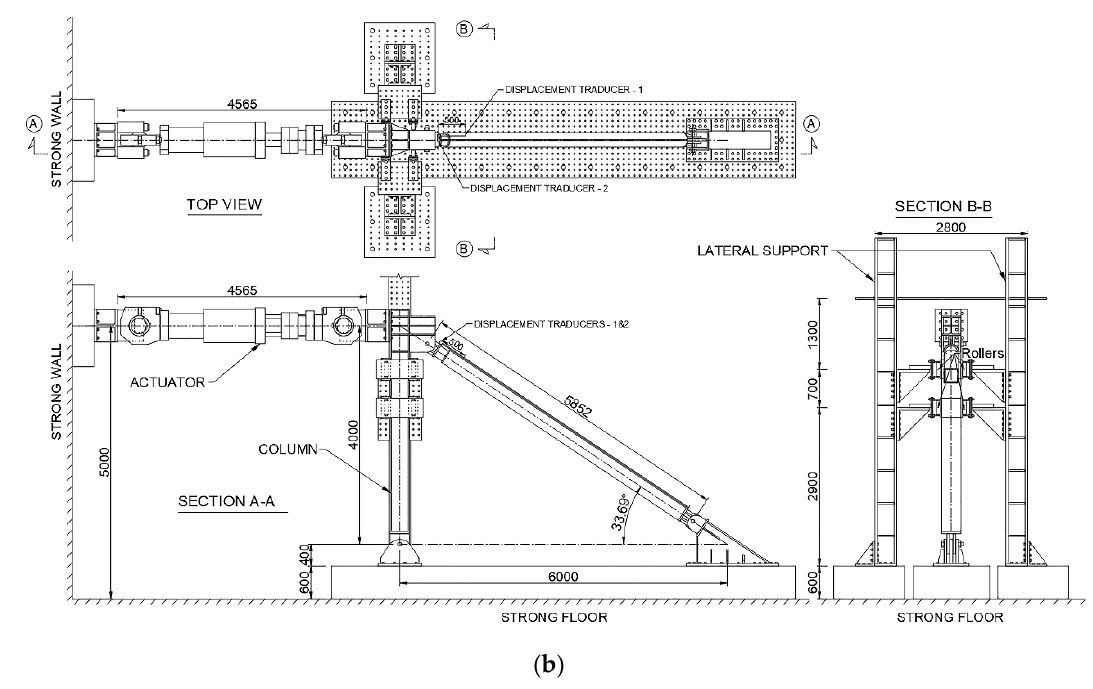
Figure 3. Test setup: ( a ) brace test and ( b ) subassembly test.